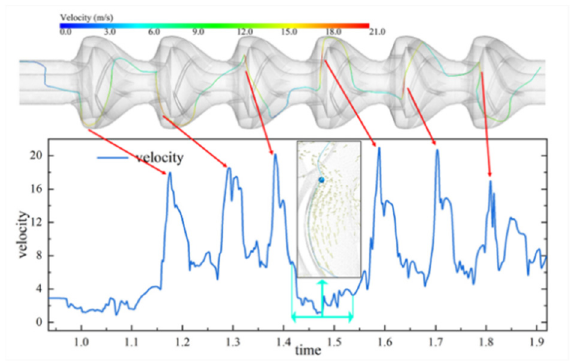
Figure 6. Lifting pump CFD–DEM particle dynamics simulation.